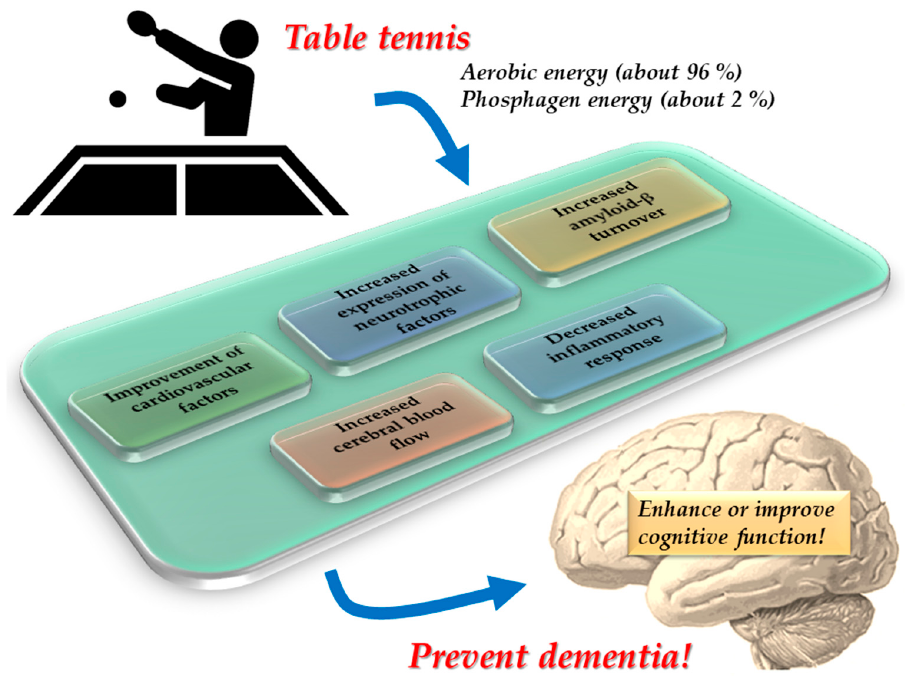
Figure 3. Possible mechanism of prevention of cognitive decline and dementia by table tennis.